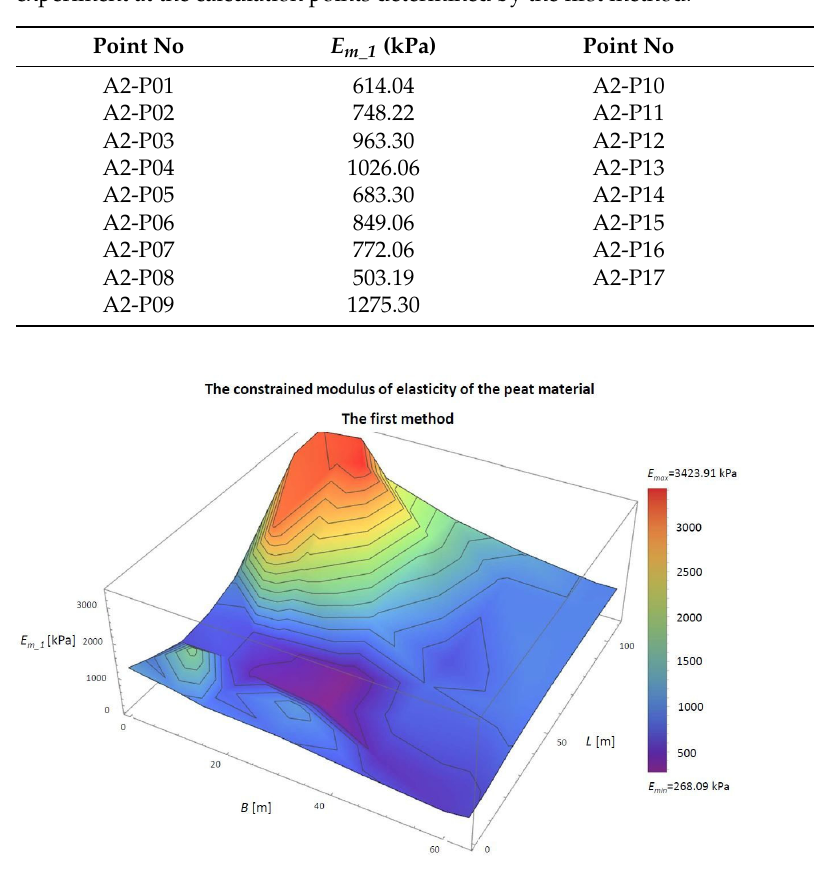
Figure 17. Distribution of the constrained modulus of elasticity values for the peat material determined with the first model under the embankment in Szczecin.